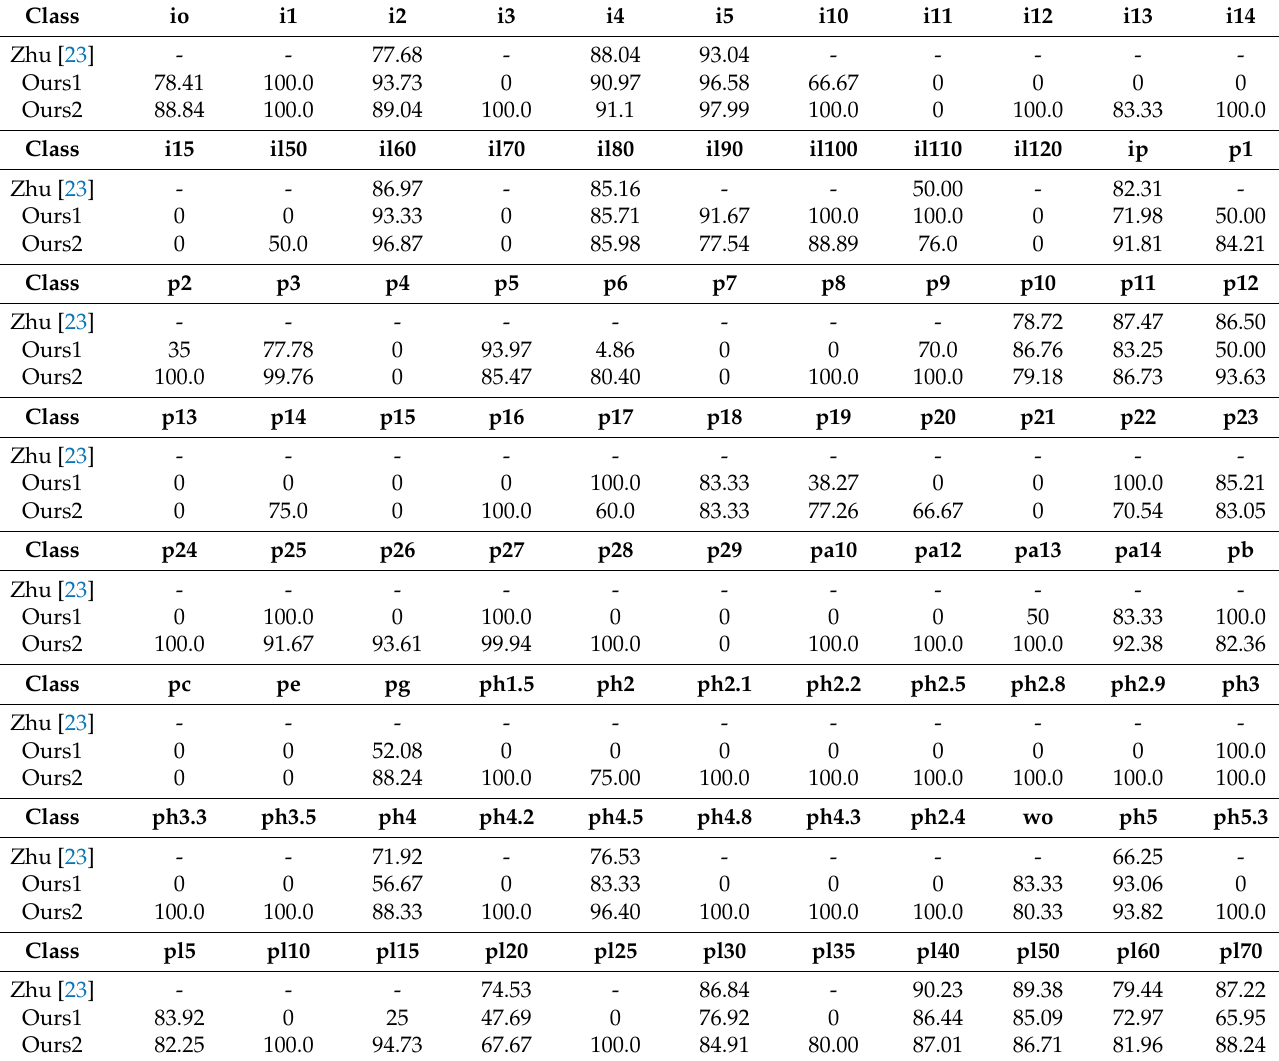
Table 5. Comparing the AP values (%) on Zhu [23] and the model in this paper, “-” indicates that the model does not contain this flag